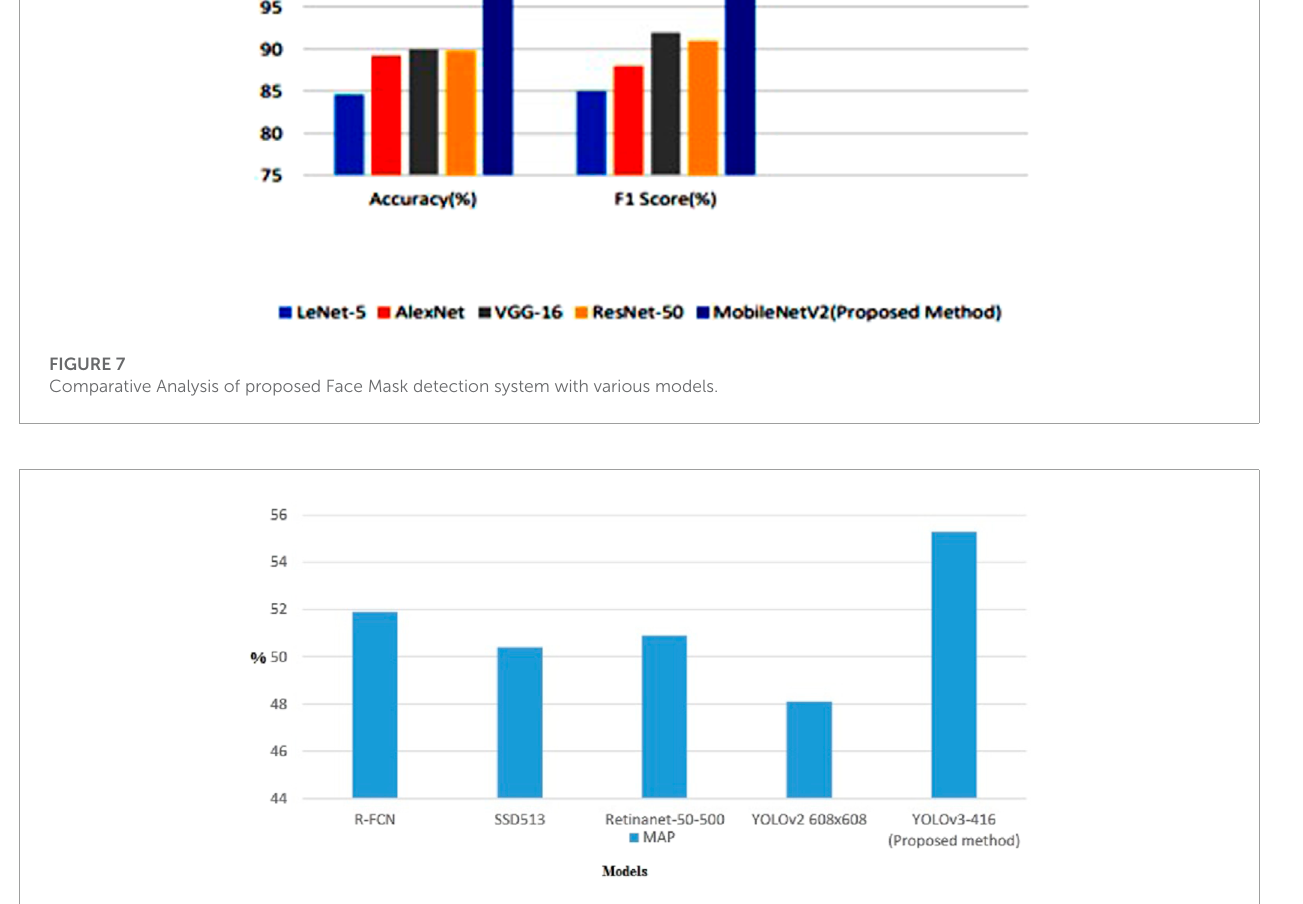
FIGURE 8 YOLOv3 vs. Other object detectors on COCO